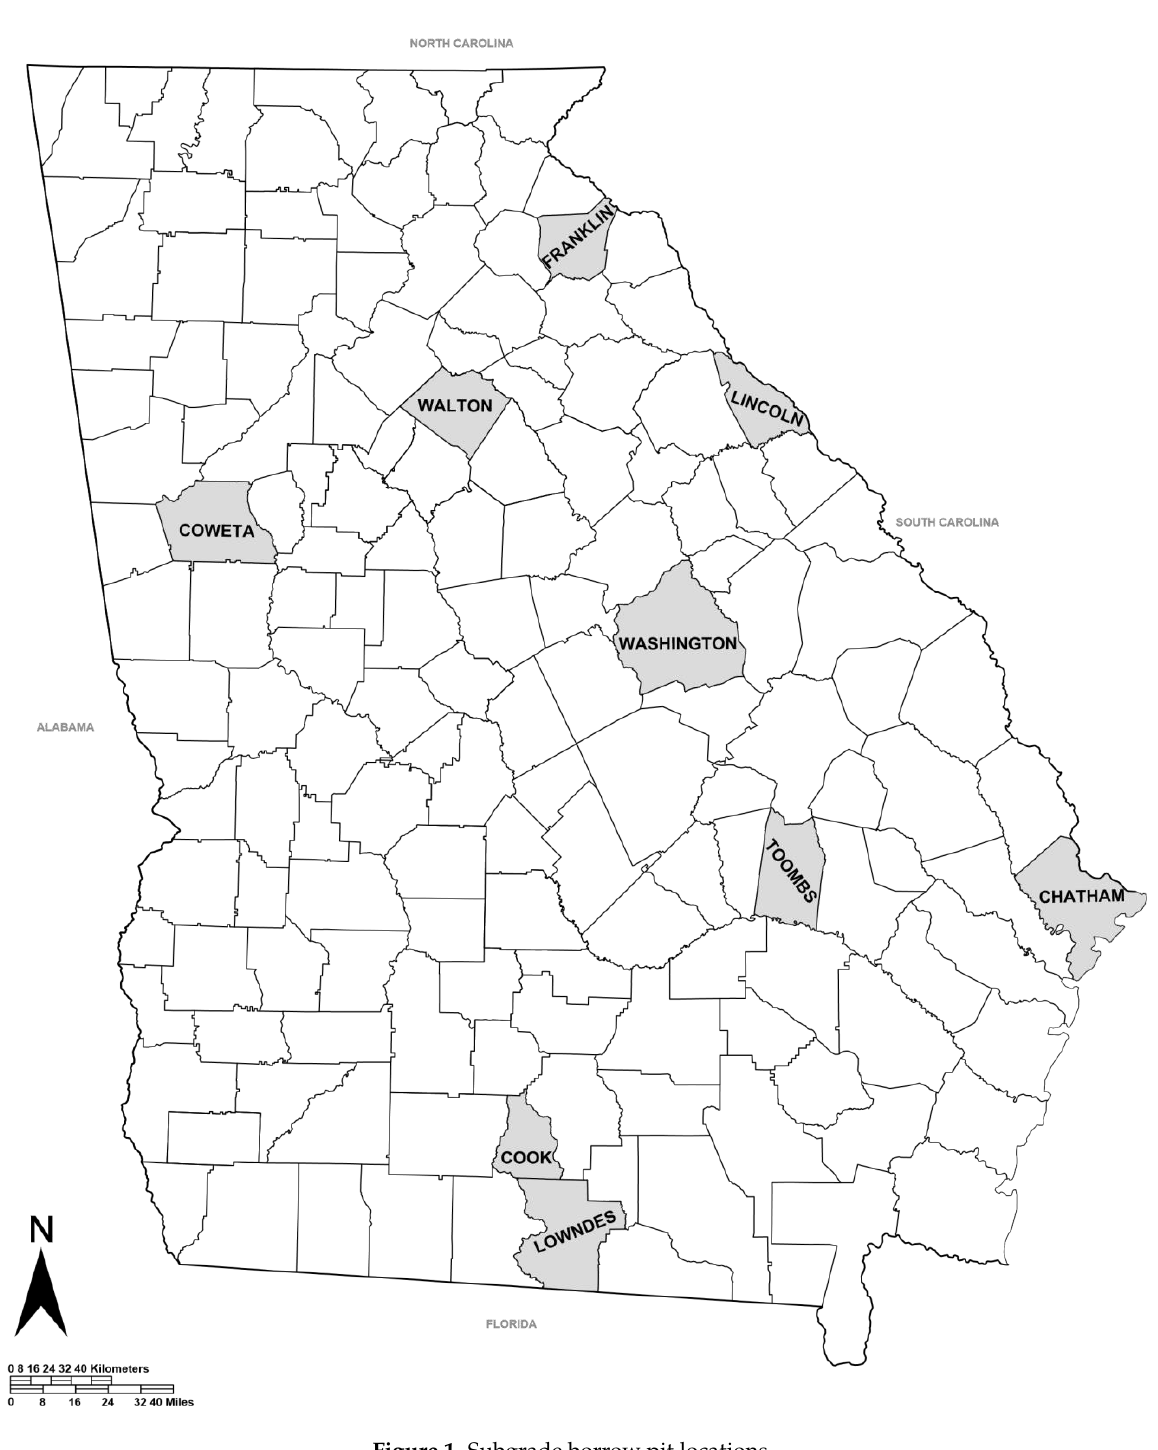
Figure 1. Subgrade borrow pit locations.